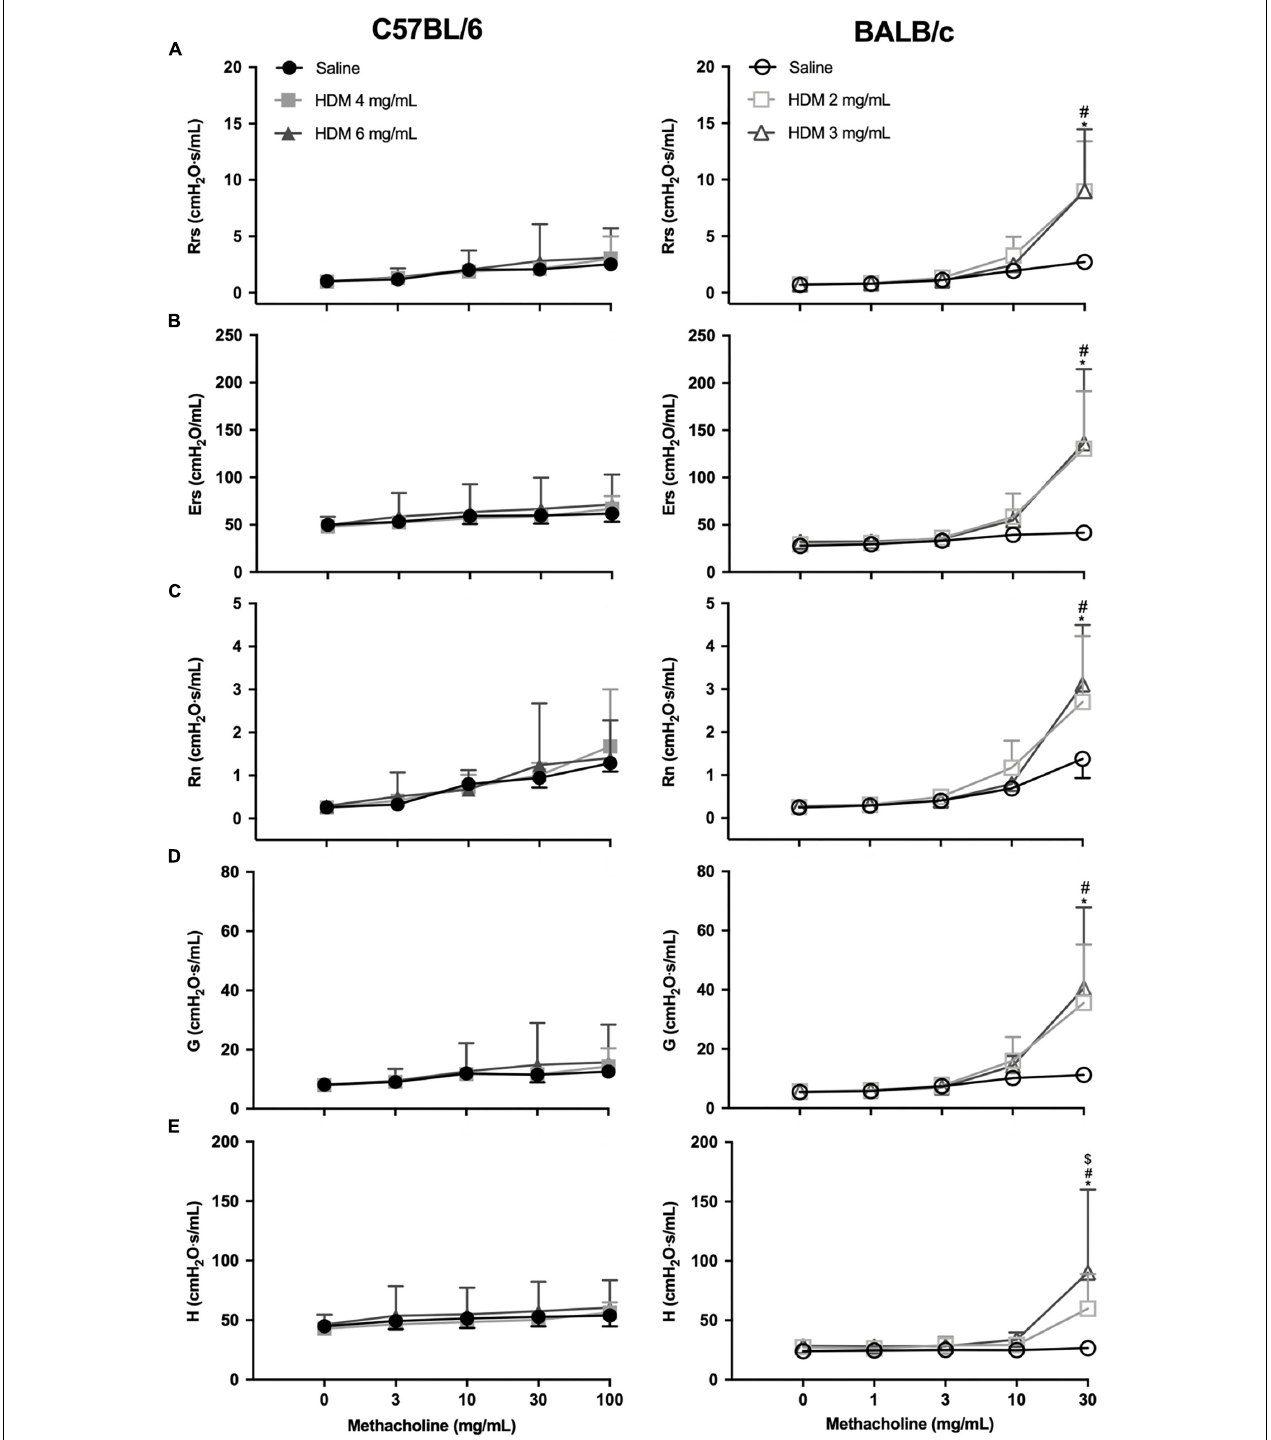
FIGURE 2 | The degree of in vivo airway responsiveness in C57BL/6 (left panels) and BALB/c (right panels) mice exposed to either saline or one of two doses of HDM. Phosphate-buffered saline and incremental doses of methacholine were delivered by nebulization and the changes in several parameters were used to evaluate the degree of airway responsiveness, including: (A) respiratory system resistance (Rrs); (B) respiratory system elastance (Ers); (C) Newtonian resistance (R N ); (D) tissue damping (G); and (E) tissue elastance (H). *, #, and $ designate significant differences in BALB/c mice for saline vs. HDM 3 mg/mL, for saline vs. HDM 2 mg/mL, and for HDM 3 vs. 2 mg/mL, respectively ( P < 0.05). Data are shown as means ± SD (some error bars seem absent because their length is smaller than the symbol). n = 10 mice per